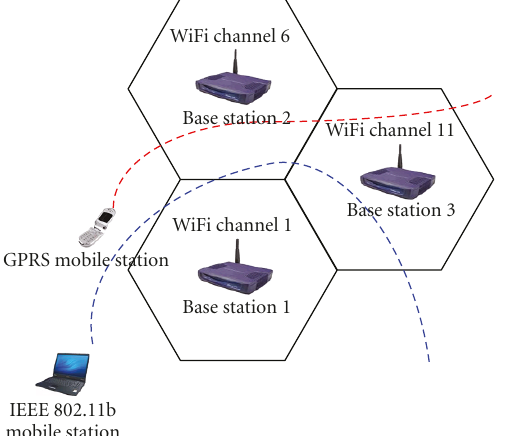
Figure 17: The network topology with three base stations in the mobile